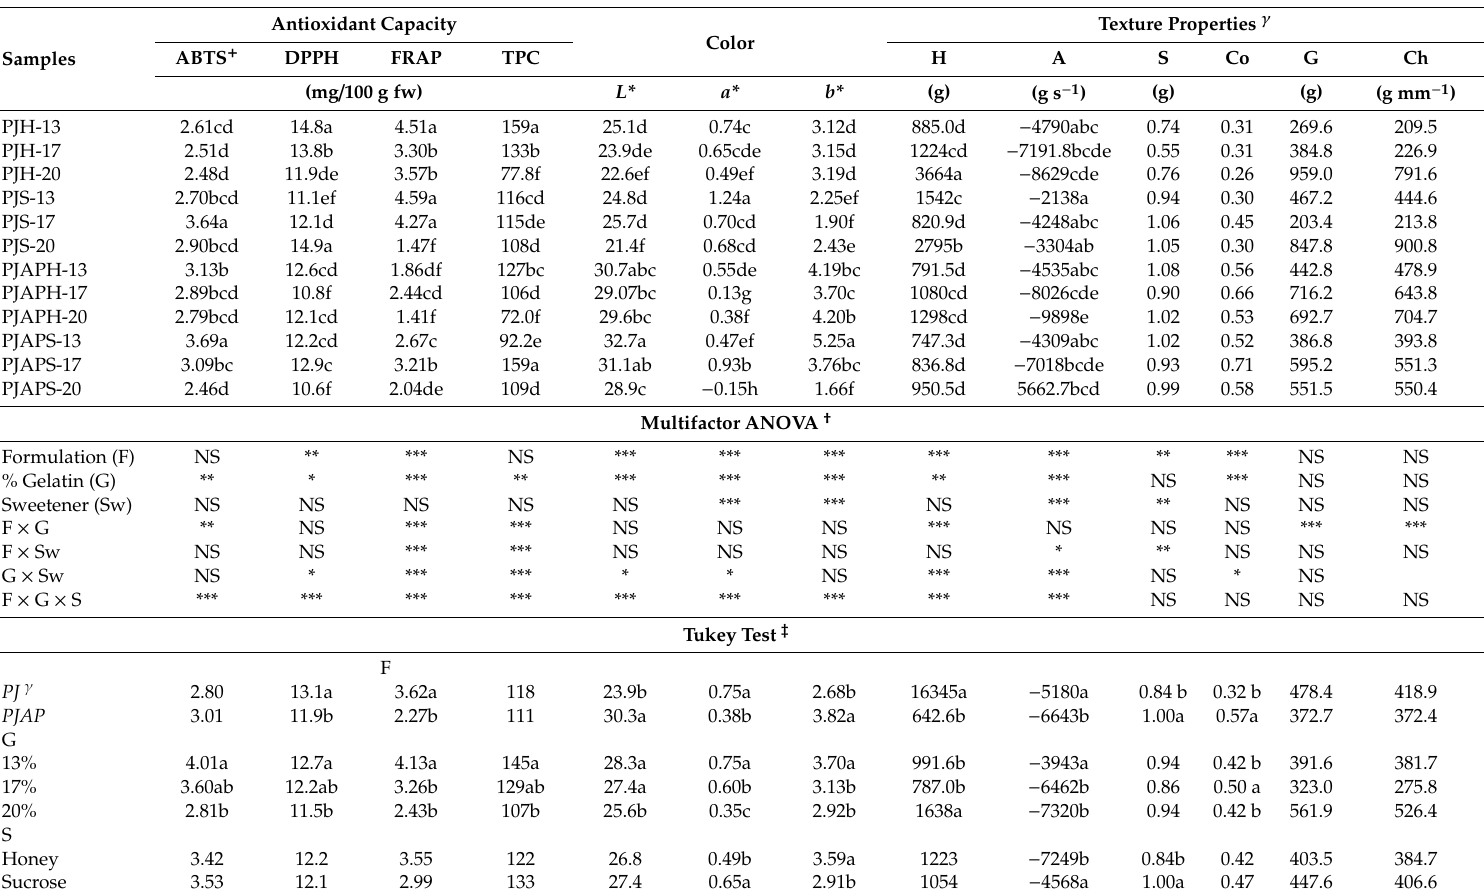
Table 2. E ff ect on antioxidant capacity, color coordinates, and texture properties of pomegranate jellies as a ff ected by formulation, gelatin percentage, and type of